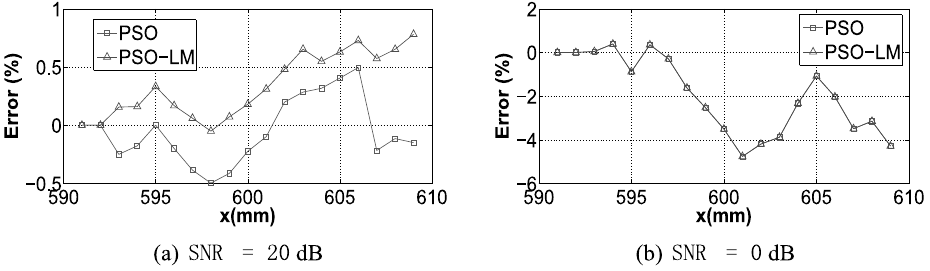
Fig. 18. Relative error in the identi fi cation for a low (0 dB) and moderate (20 dB) levels of SNR, Case 2 (Part